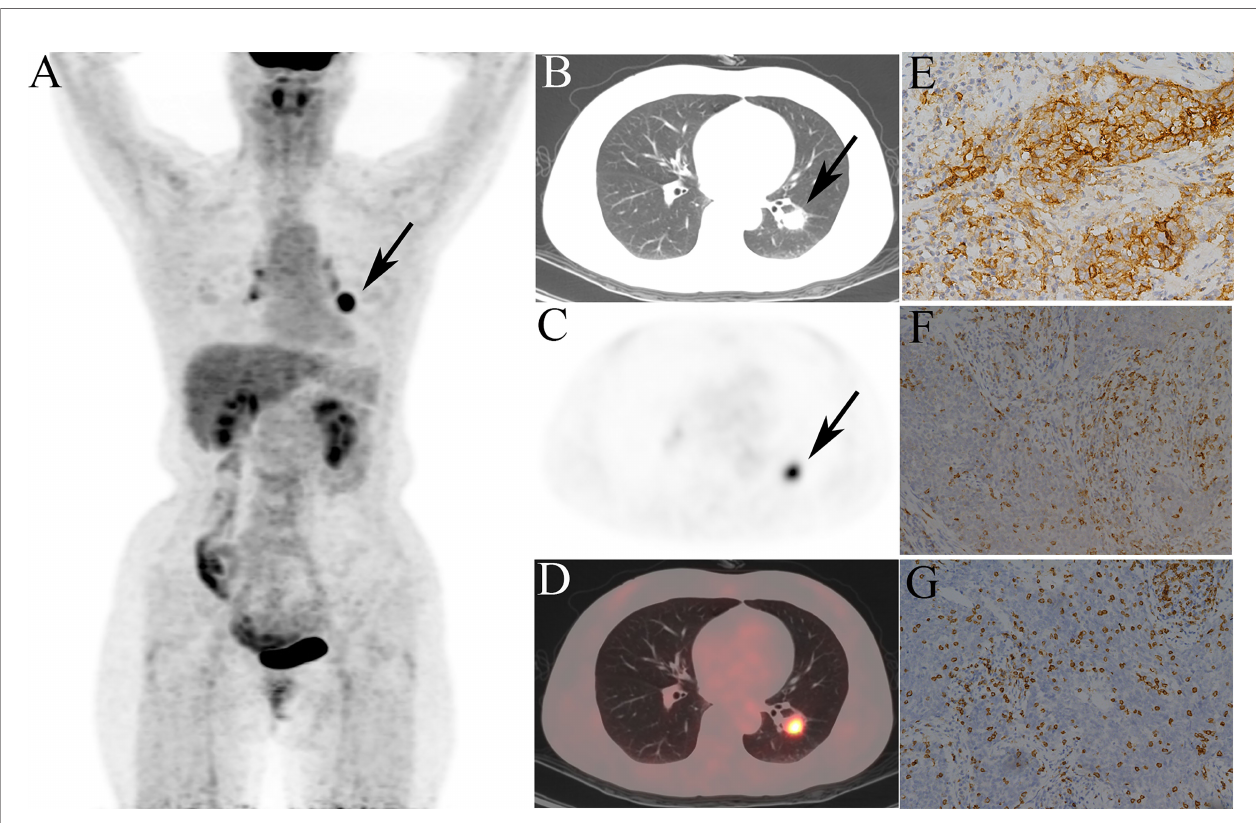
FIGURE 7 | Representative 18 F- fl uorodeoxyglucose positron emission tomography/computed tomography ( 18 F-FDG PET/CT) images of a 52-year-old female patient, de fi ned as tumor microenvironment immune type (TMIT)-I tumor. (A) MIP fi gure, (B – D) CT, PET, PET/CT fusion images. A nodule was in the lower lobe of the left lung (arrow) with markedly increased radioactivity, SUVmax: 10.3, GLRLM_LRHGE: 382, GLZLM_SZE: 0.682, and GLCM_Contrast: 14.6. The surgical pathology: poorly moderately differentiated squamous cell carcinoma. (E) High programmed death-ligand 1 (PD-L1) expression. (F) Programmed death-1 (PD-1) tumor-in fi ltrating lymphocytes (TILs) high density. (G) CD8+ TILs high